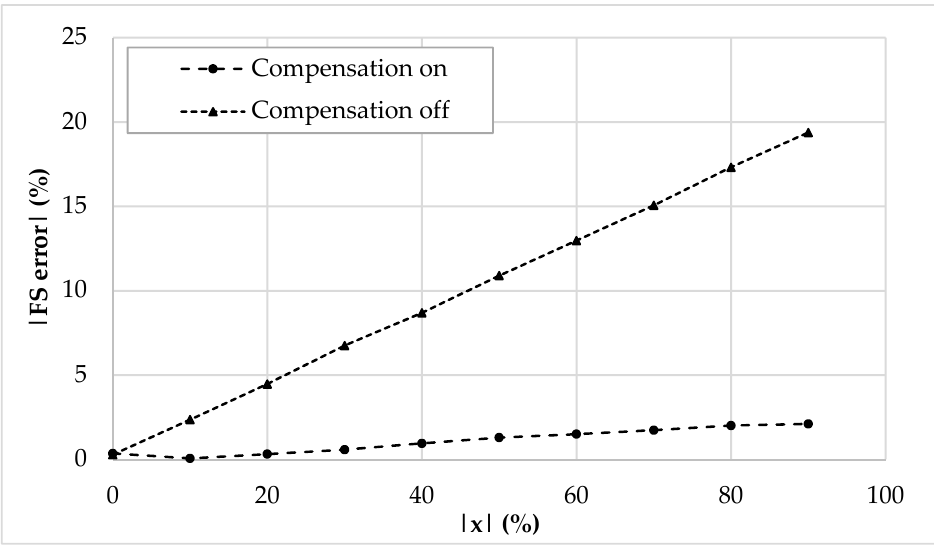
Figure 7. Full-scale error (%) of the compensated and uncompensated integrated interface.